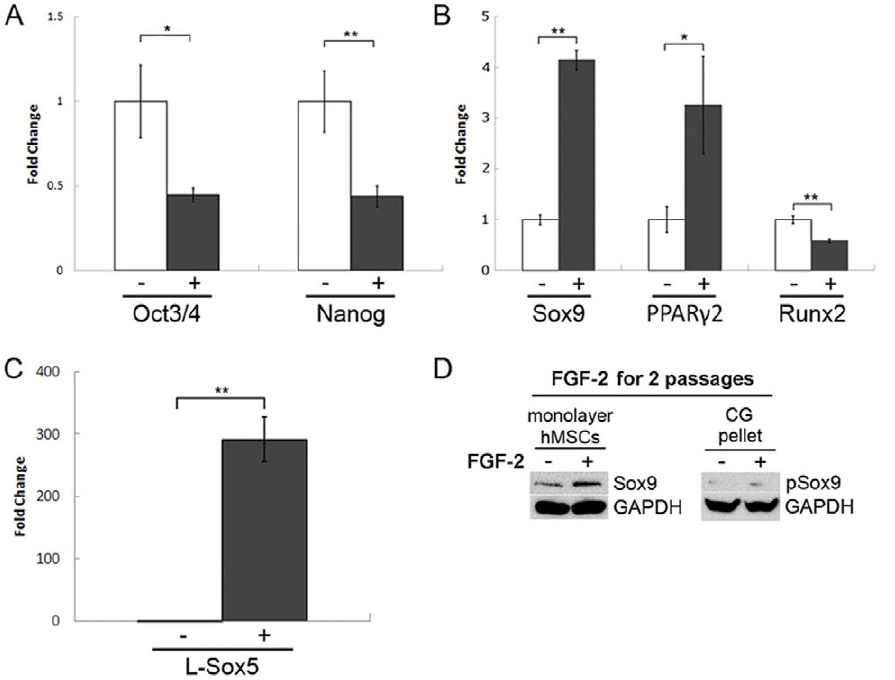
Figure 2. FGF-2 reduces potency and modulates lineage-specific transcription factor expression of hMSCs. Human MSCs were expanded for 2 passages in 5% FBS with ( + ) or without ( 2 ) FGF-2 supplementation and assayed for gene and protein expression prior to pellet culture. (A, B, C) Real-time RT-PCR analysis demonstrated that FGF-2-expanded hMSCs significantly downregulated the expression of embryonic stem cell markers (A), modulated the expression of key lineage-specific transcription factors (B), and upregulated the expression of L-Sox5 (C). All values were normalized to GAPDH expression and compared to the non-FGF-2-expanded control. Values are represented as mean 6 SD. *p , 0.05, **p , 0.005, n=3. (D) Western blot analysis showed that FGF-2-expanded hMSCs exhibited higher Sox9 protein levels than non-FGF-2-expanded hMSCs prior to CG, and after pellet formation, pSox9 protein levels were present at higher levels. GAPDH was used as a loading control.